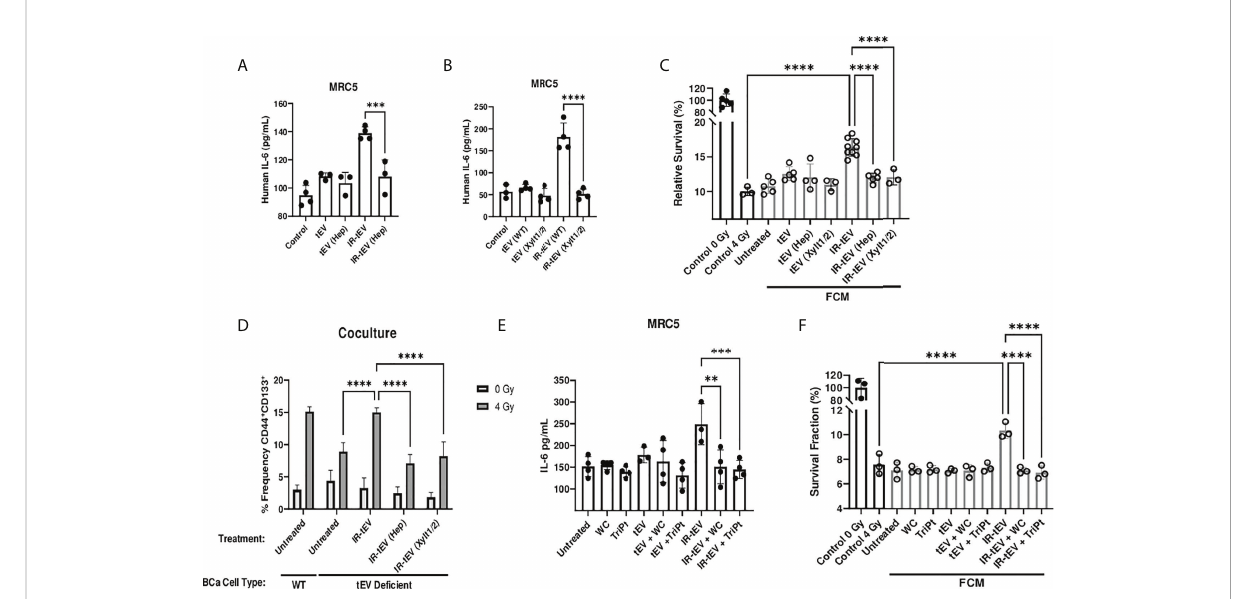
FIGURE 6 IR-tEV activity is dependent upon exosomal heparan sulfate. (A) MRC5 cells were stimulated with MDA-MB-231 derived tEVs enzymatically stripped of HS. IL-6 levels were measured via ELISA. (B) MRC5 cells were stimulated with tEVs collected from WT or Xylt1/2 KO MDA-MB-231 cells. IL-6 levels were measured via ELISA. (C) MDA-MB-231 were exposed to fresh media containing tEV stimulated MRC5 conditioned media described in (A, B) and radioresistance was assessed via clonogenic assay. X axis indicates which fi broblast CM from (A, B) was used in the incubation. (D) WT or SDC1 KO (tEV De fi cient) cells were plated with MRC5 cells with or without the addition of WT IR-tEVs pretreated with heparanase. Protein surface markers were assessed via fl ow cytometry. (E) MRC5 cells were incubated with tEVs pretreated with 50 uM Triplatin or Werner ’ s Complex. IL-6 levels were measured via ELISA (F) MDA-MB-231 were exposed to fresh media containing IR-tEV stimulated MRC5 conditioned media described in (E) and radioresistance was assessed via clonogenic assay. X axis indicated what FCM from (E) was used in each incubation. Statistical signi fi cance assessed with ANOVA P < 0.05. Data points represent biological replicates. ** denotes a P value < 0.005. *** denotes a P value < 0.0005. **** denotes a P value < 0.00005. These values were the results of ANOVA analyses performed on